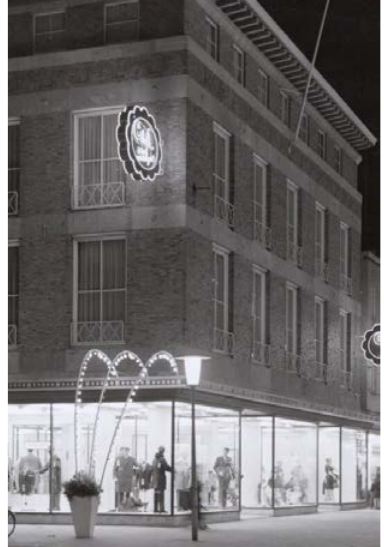
Fig. 11 Original Etalage at C&A Building in